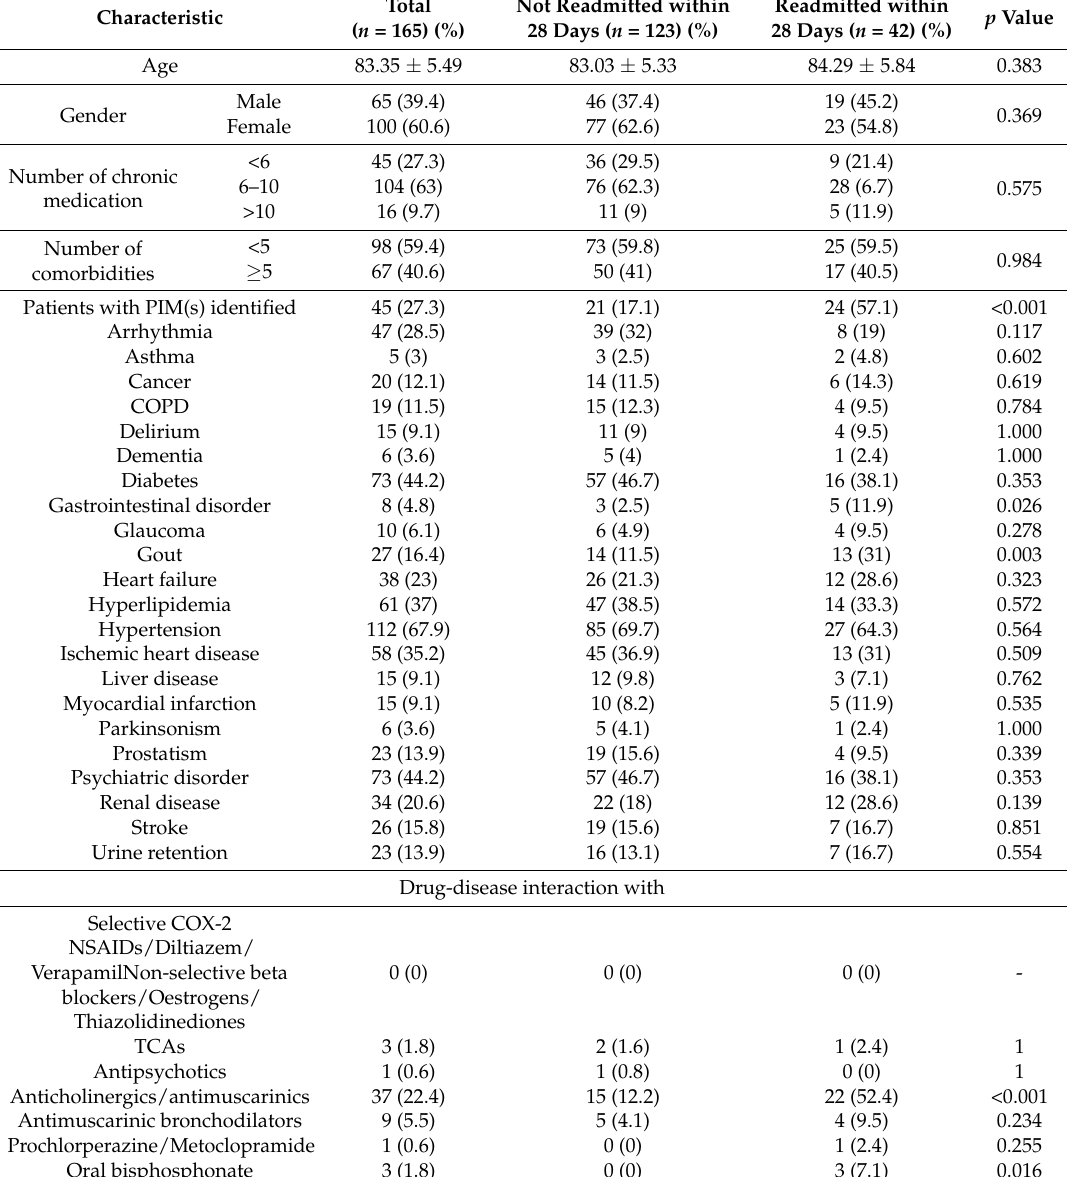
Table A1. Characteristics of the study